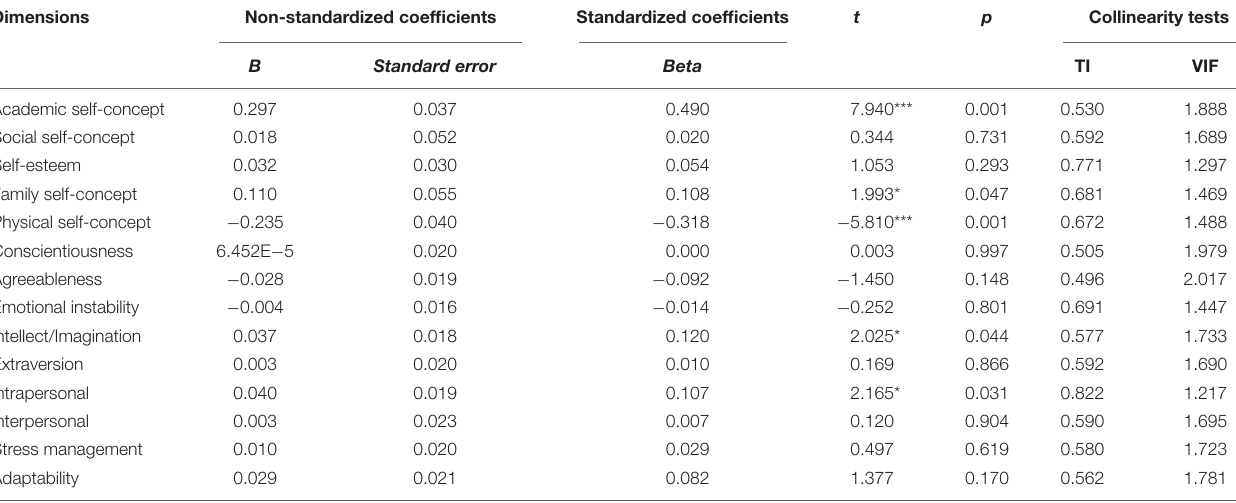
TABLE 4 | Regression analysis of the different dimensions analyzed with respect to the natural sciences subject. Dimensions